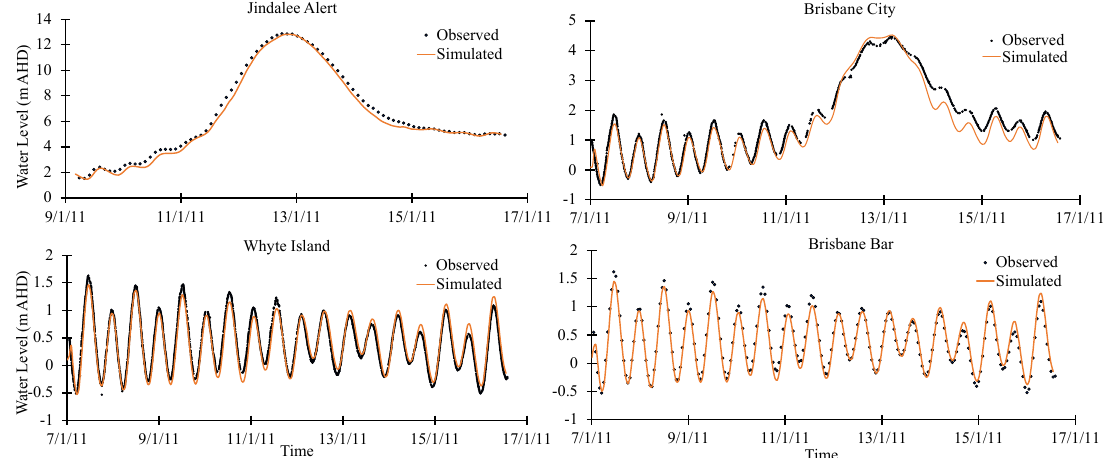
Figure 7. Observed and simulated water levels for the 2011 flood event at Jindalee Alert, Brisbane city, Whyte Island, and Brisbane Bar.